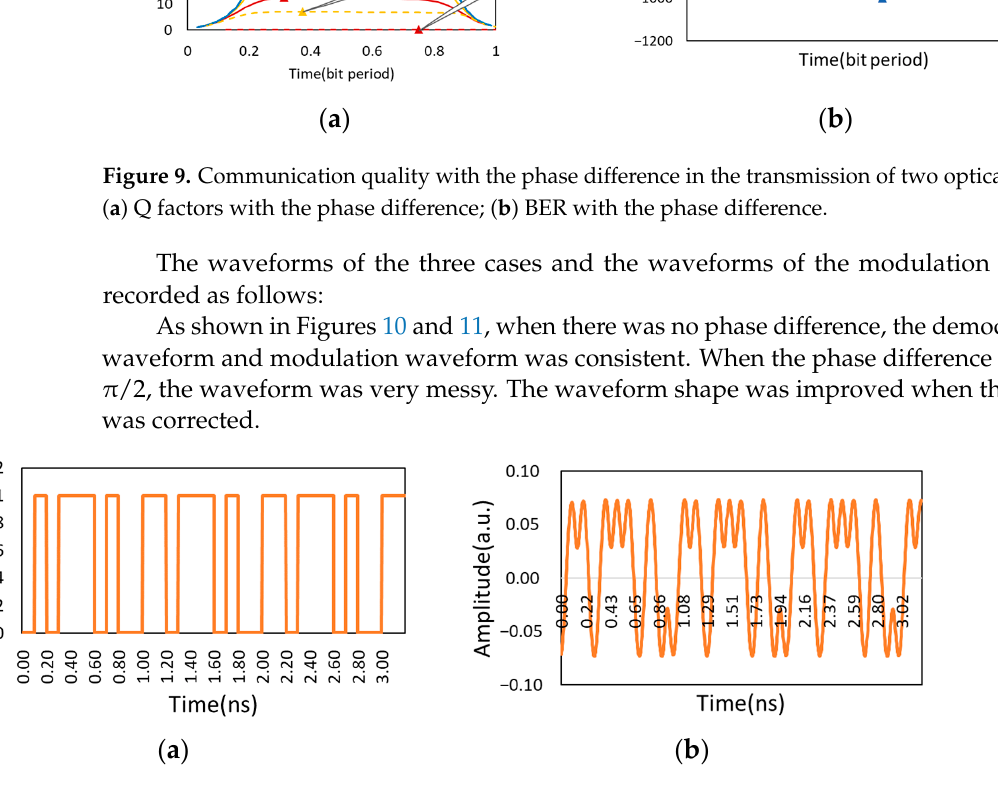
Figure 9. Communication quality with the phase difference in the transmission of two optical sig- nals: ( a ) Q factors with the phase difference; ( b ) BER with the phase difference.